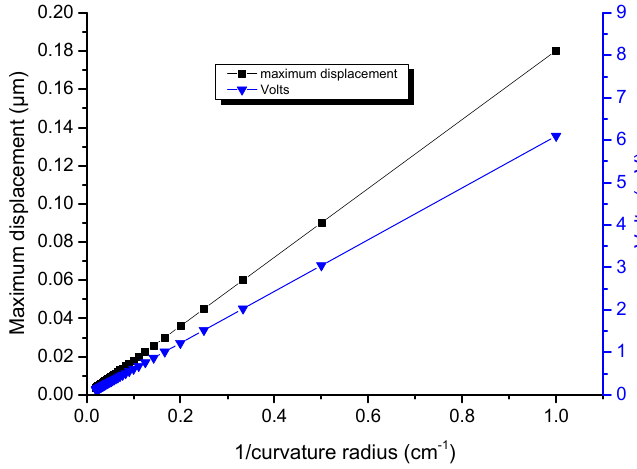
Figure 4. Maximum displacement and output voltage as function of the curvature radius ρ for a single wire embedded in a capacitive structure. The maximum displacement occurs at the wire extremities and the potential value is taken at the middle of the top facet of the wire (see point M in Figure 3).